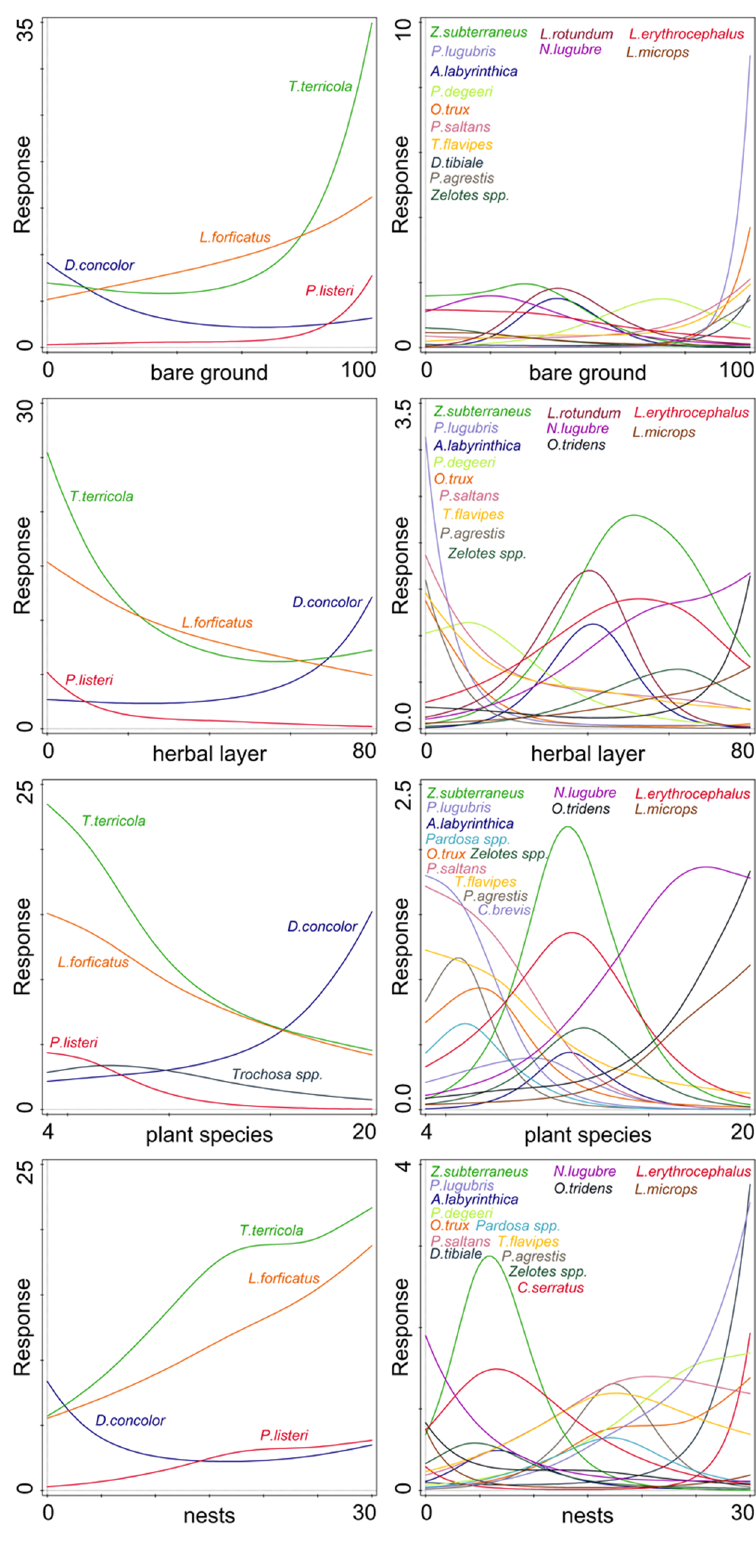
Figure 3. Effect of significant factors on the activity-density of species with a significant response (see Table 2). Left column—numerous species ( ˃ 50 specimens); right column—less numerous species (20–50 specimens); bare ground—percentages of patches without vegetation; herbal layer—coverage (%) of ground by herbs; plant species—number of plant species; nests—mean number of cormorant nests per 100 m 2 .